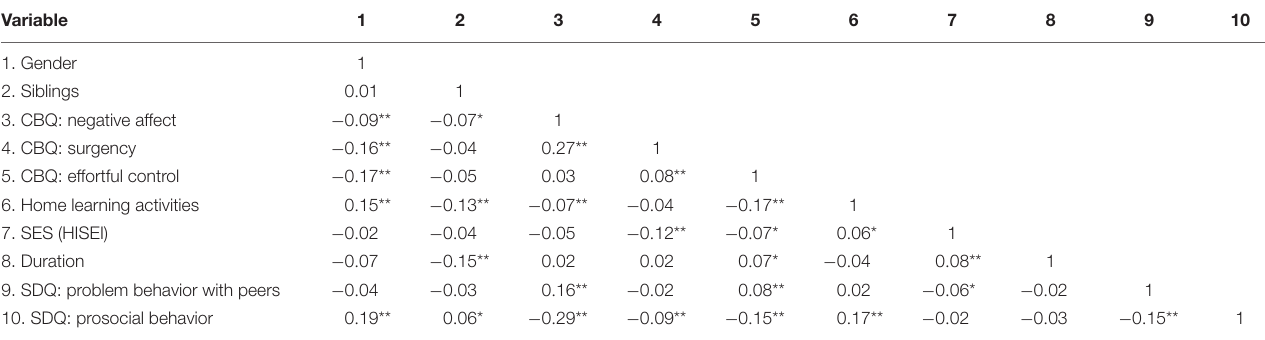
TABLE 6 | Bivariate correlations (two-tailed) of social competencies for children without a migration background. Variable